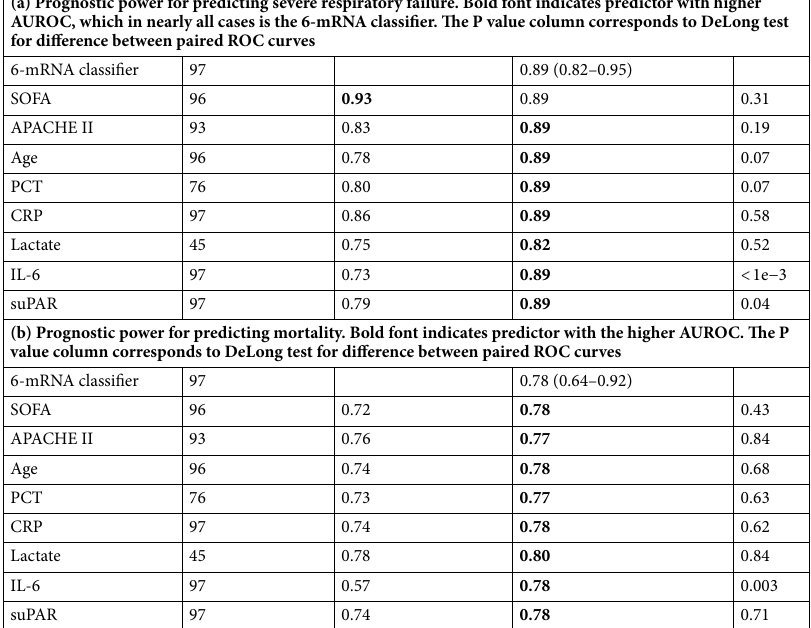
Table 3. Prognostic power of the 6-mRNA signature classifier and comparator scores and markers in the independent prospective COVID-19 cohort. Shown are AUROCs for non-missing data, plus 95% CI. The fourth column is a ‘fair’ assessment of the 6-mRNA signature classifier, i.e. the performance on the subset of patients that was available to the